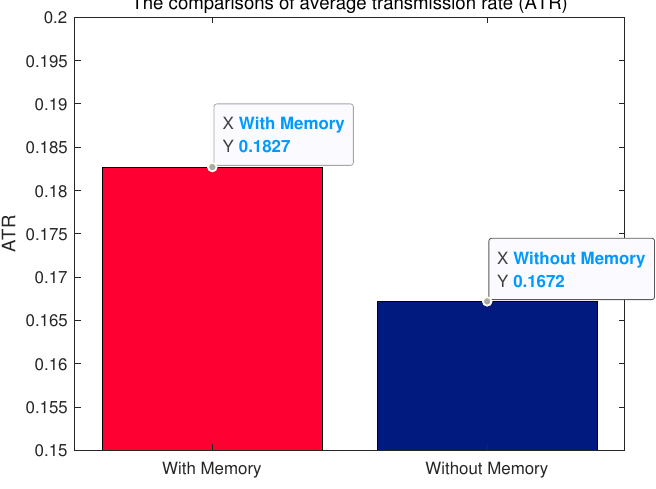
Figure 11. The comparisons of the ATR with/without